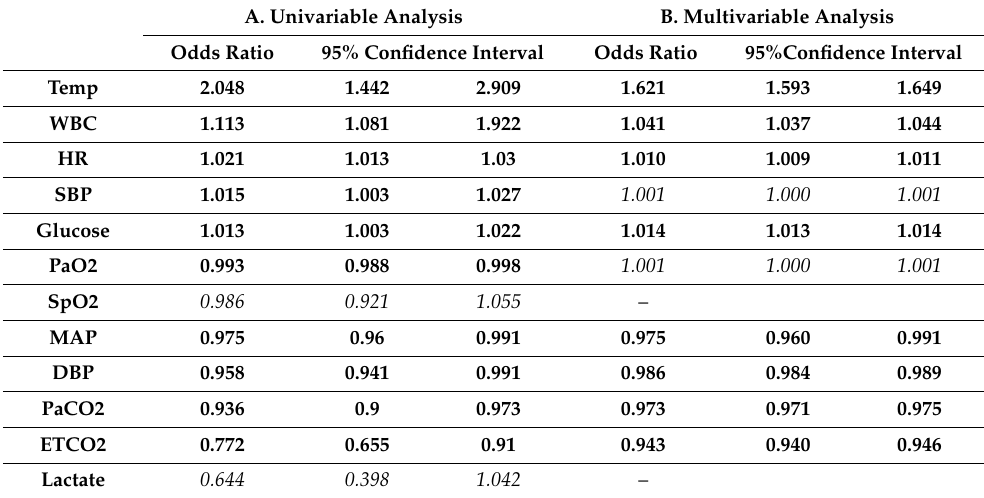
Table 2. ( A ) Univariate logistic regression and ( B ) multivariable logistic regression with variables sorted by predictive